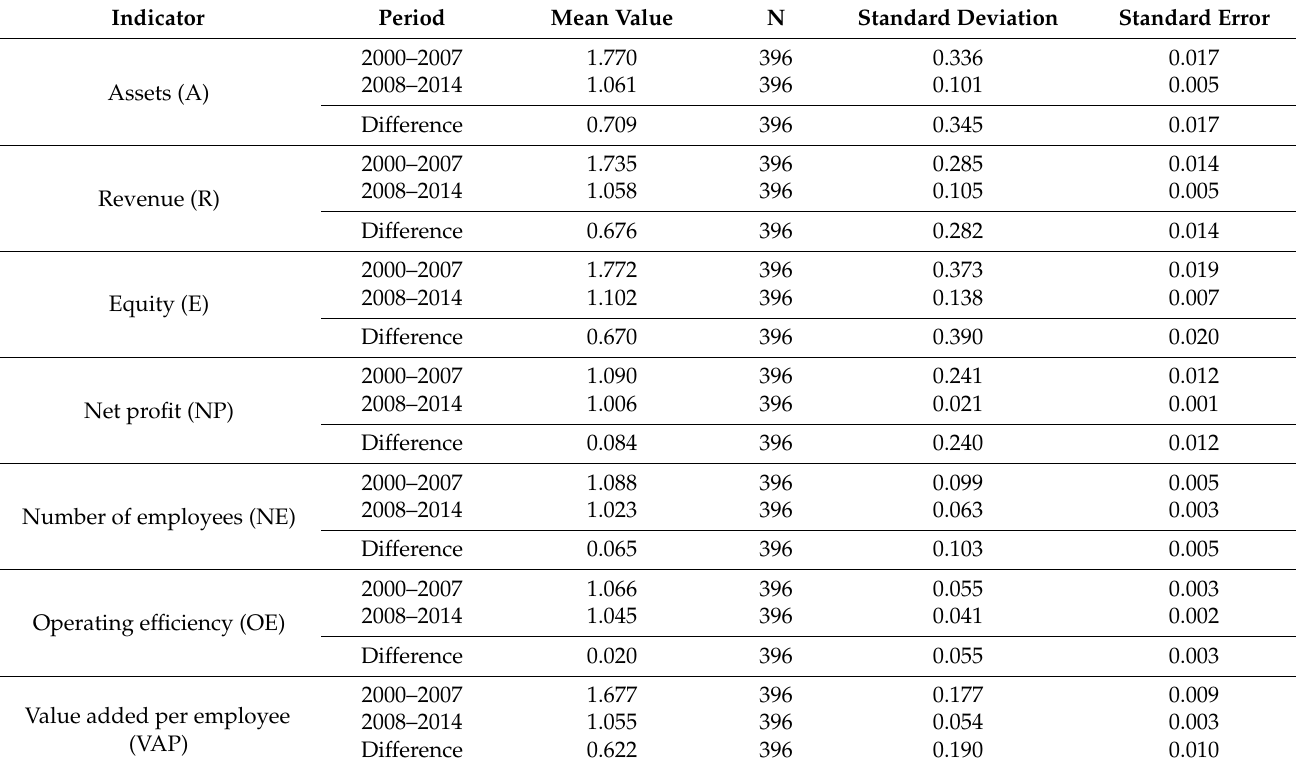
Table 3. Comparisons of the mean values and their differences for the economic and financial indicators indices in the two financial periods.